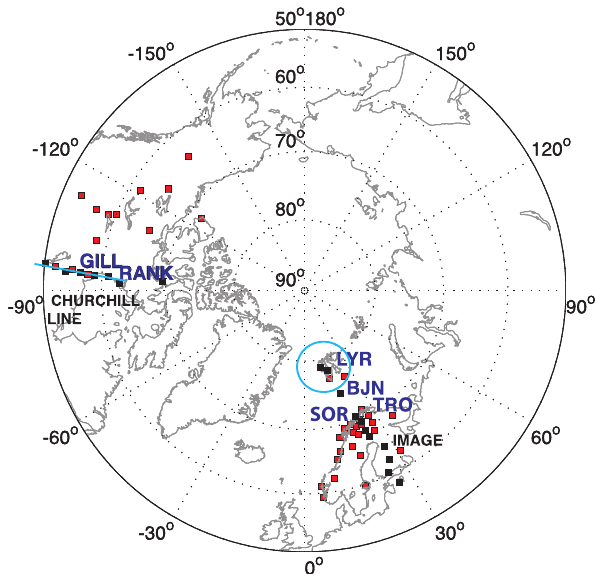
Fig. 2. Meridionally selected magnetometer stations of the IMAGE and CARISMA networks (black diamonds) that were used for the calculations of 1-D equivalent currents are plotted on the map. The meridional CARISMA line is frequently referred to as the Churchill line. Red and black diamonds together mark the stations of IMAGE and CARISMA networks (all available) that were used to calculate the local electrojet indices IL/IU and CL/CU, respectively. The opti- cal and radar stations used in this study are labelled. The cyan circle and line mark the fields-of-view of an all-sky camera and meridian scanning photometer that are also used in this study. Stations that are closest to the onset locations and that are mentioned in the text are also labelled on the